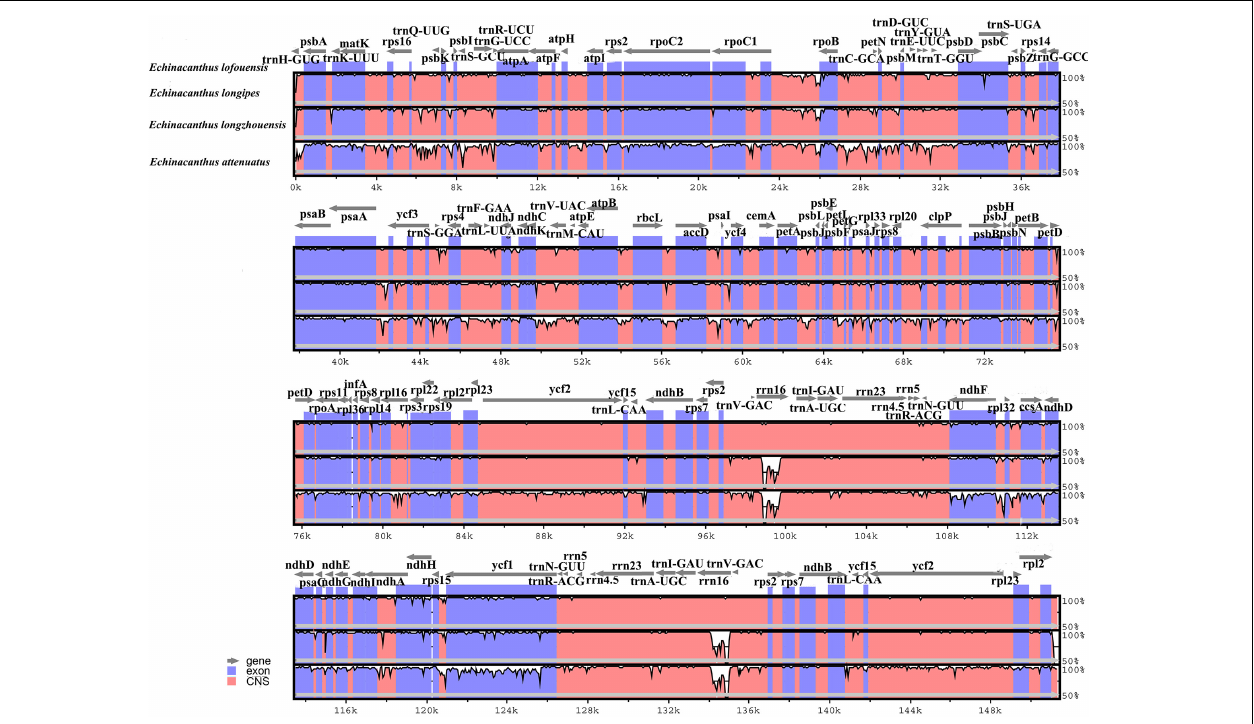
FIGURE 3 | Comparison of four Echinacanthus chloroplast genomes using mVISTA program, taking the annotation of E. lofouensis as a reference. The top line shows the genes in order. A cut-off of 70% identity was used for the plots and the Y-scale represents the percent identity between 50 and 100%. Genome regions are color-coded as exon and conserved non-coding sequences (CNS).